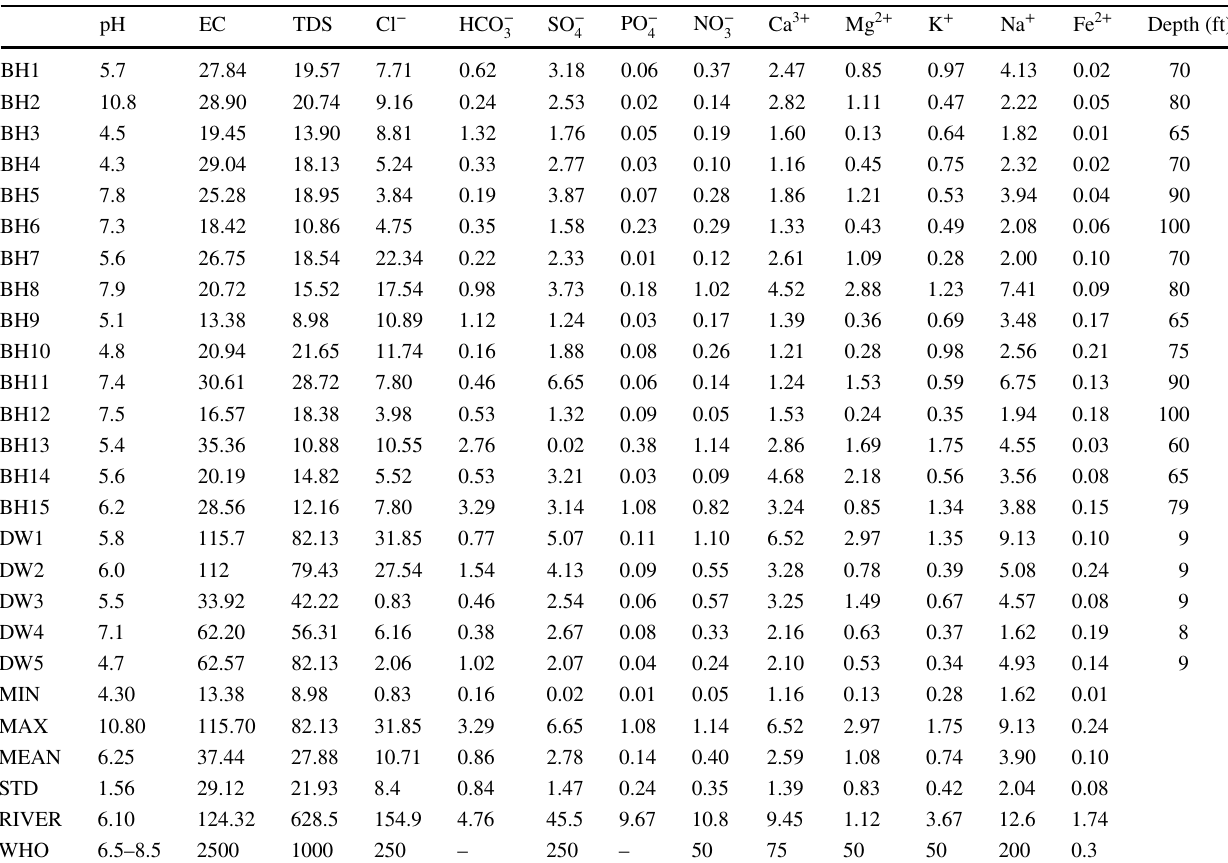
Table 2 Physio-chemical properties of groundwater obtained from borehole and hand-dug wells in the study area